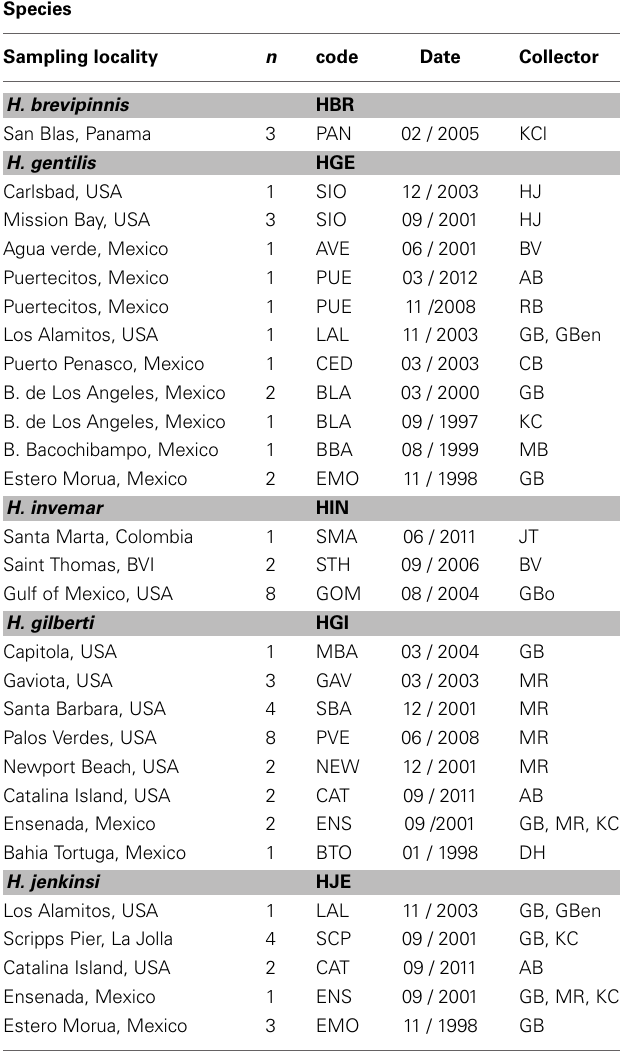
Table 1 | Sampling localities.